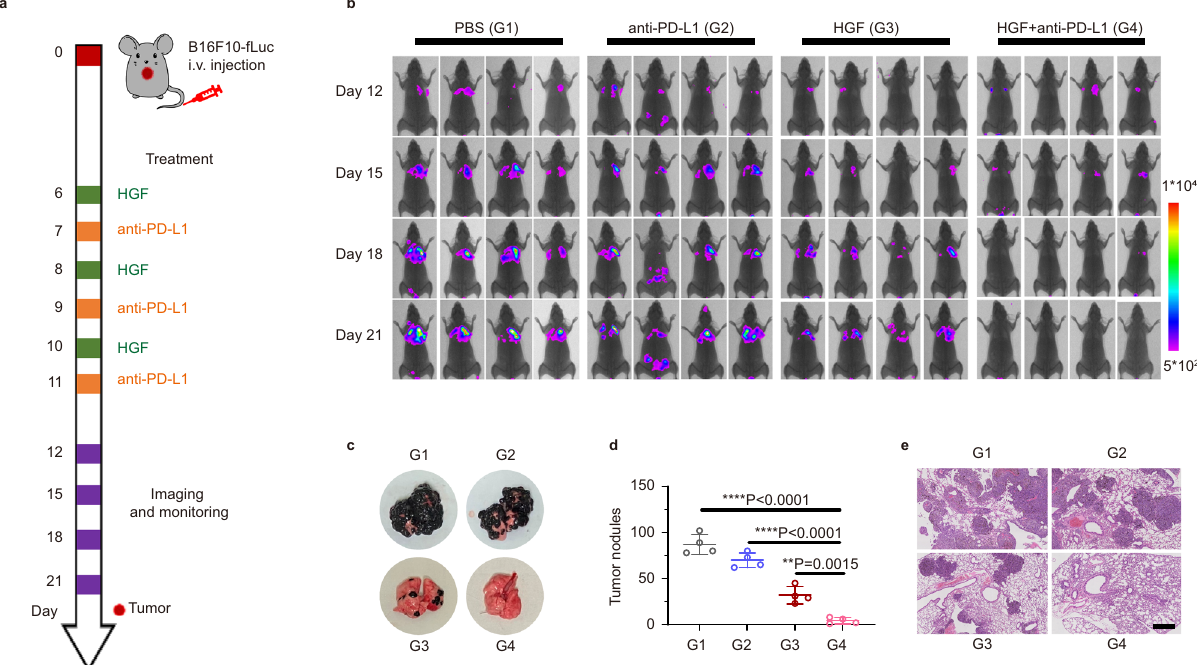
Fig. 7 Combined HGF and anti-PD-L1 immunotherapy inhibited melanoma metastasis effectively. a C57BL/6 mice were intravenously (i.v.) injected with 1 × 10 5 B16F10-FLuc cells, treated with PBS, anti-PD-L1, HGF (day 6, day 8, and day 10), or HGF every 2 days from day six for three times, and anti-PD-L1 on day 7, day 9, and day 11 (HGF + anti-PD-L1). b Respective bioluminescence images of metastatic B16F10-FLuc cells in mice body on day 12, day 15, day 18, and day 21. c Representative photographs of tumor nodules in lungs on day 21. d Number statistics of tumor nodules on lungs on day 21 after treatment. e H&E-stained slice images of lungs. Scale bar: 400 μ m. Data were presented as mean ± SD. n = 4 biologically independent animals per group. Statistically signi fi cant differences between groups were identi fi ed by one-way ANOVA with Tukey ’ s post hoc test. * P < 0.05, ** P < 0.01, *** P < 0.001, and **** P <